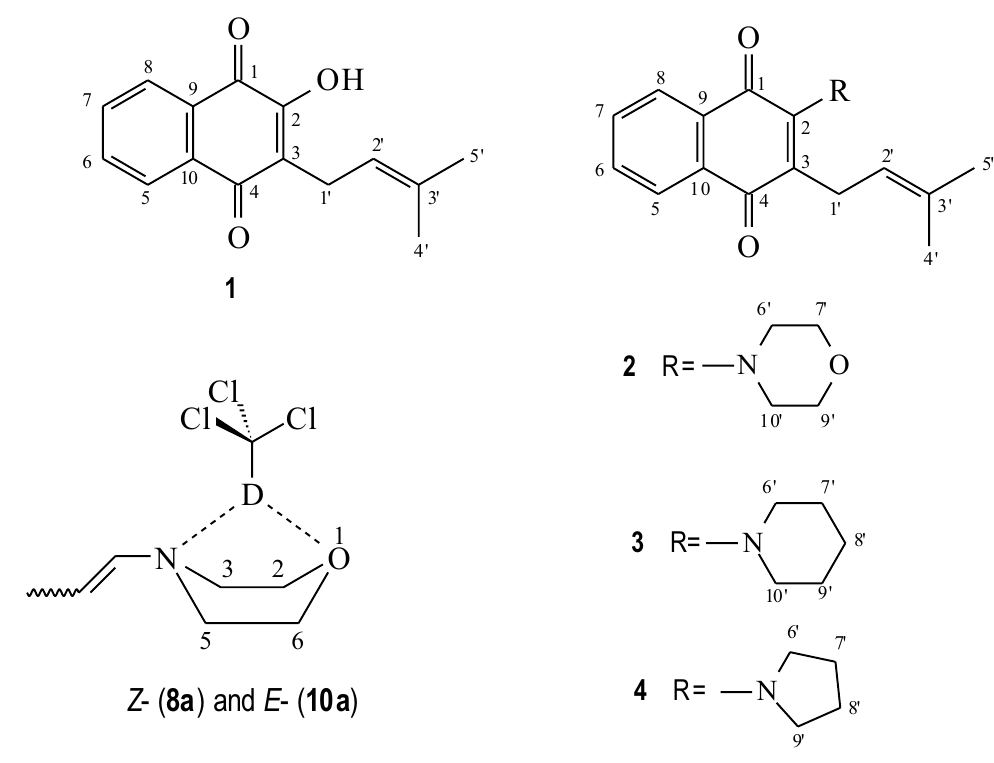
Fig. 1 – Structures lapachol ( 1 ), lapachol derivatives ( 2,3,4 ) and model compounds 8 and 10 involved in intermolecular hudrogen bond with CDCl 3 ( 8a and 10a